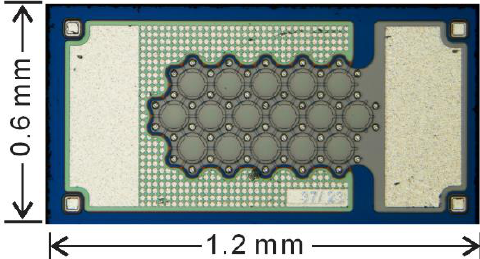
Figure 2. Capacitive pressure sensor die from Protron with which the interface is designed to work.